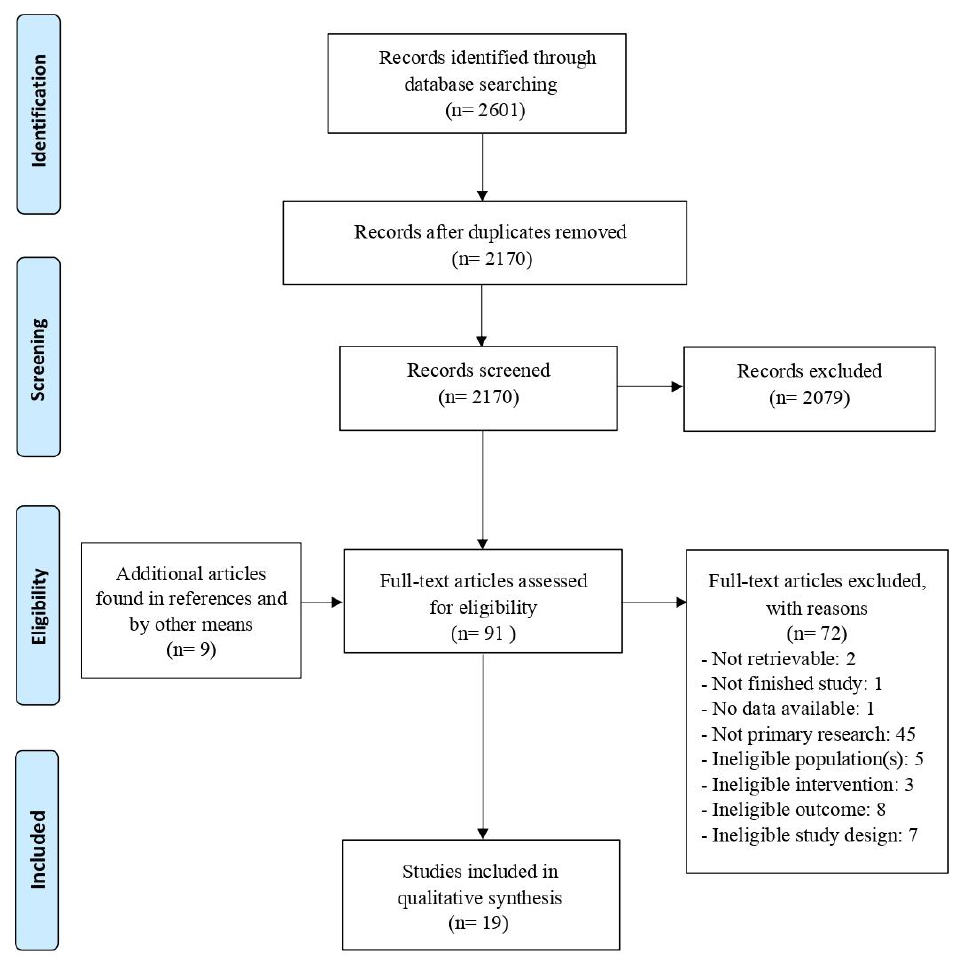
Figure 1. PRISMA flow diagram outlining study selection [81].